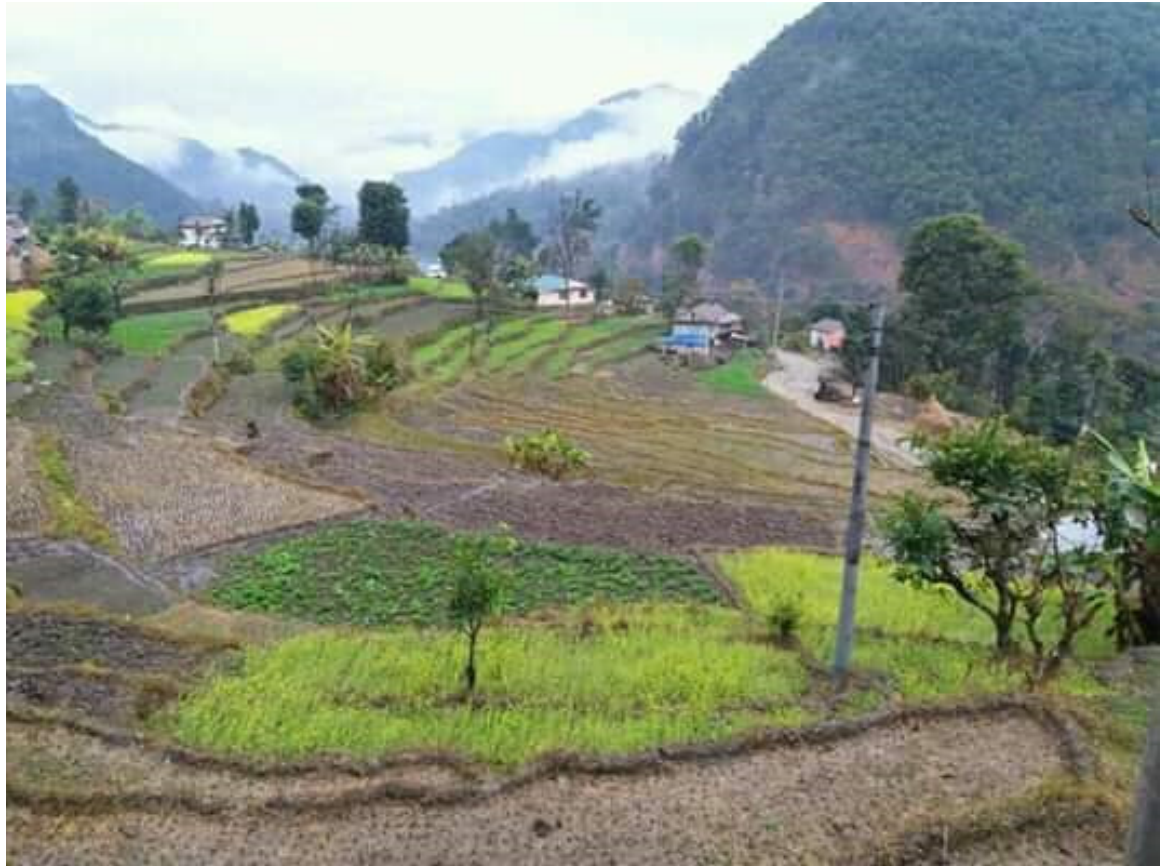
Figure 4. Ultra-small private land parcels in the mountain: a common land-sharing practice to survive in limited availability of safely farming and fertile lands.